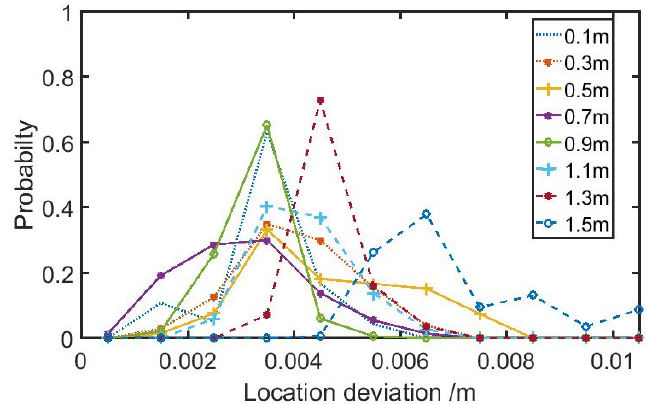
Figure 5. The localization deviation when the ultrasonic source was positioned at X = 1 m and Y = 1 m, yet with variable Z from 0.1 m to 1.5 m.